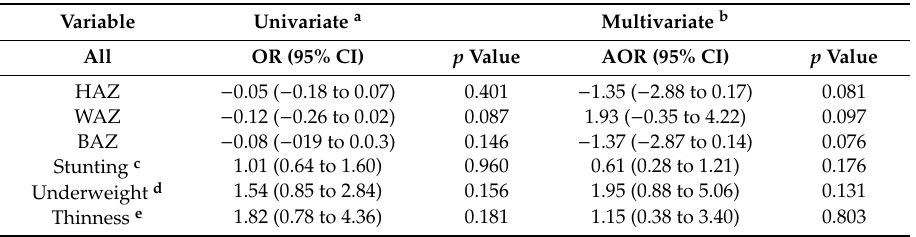
Table 4. Association between dietary diversity and nutritional indicators.